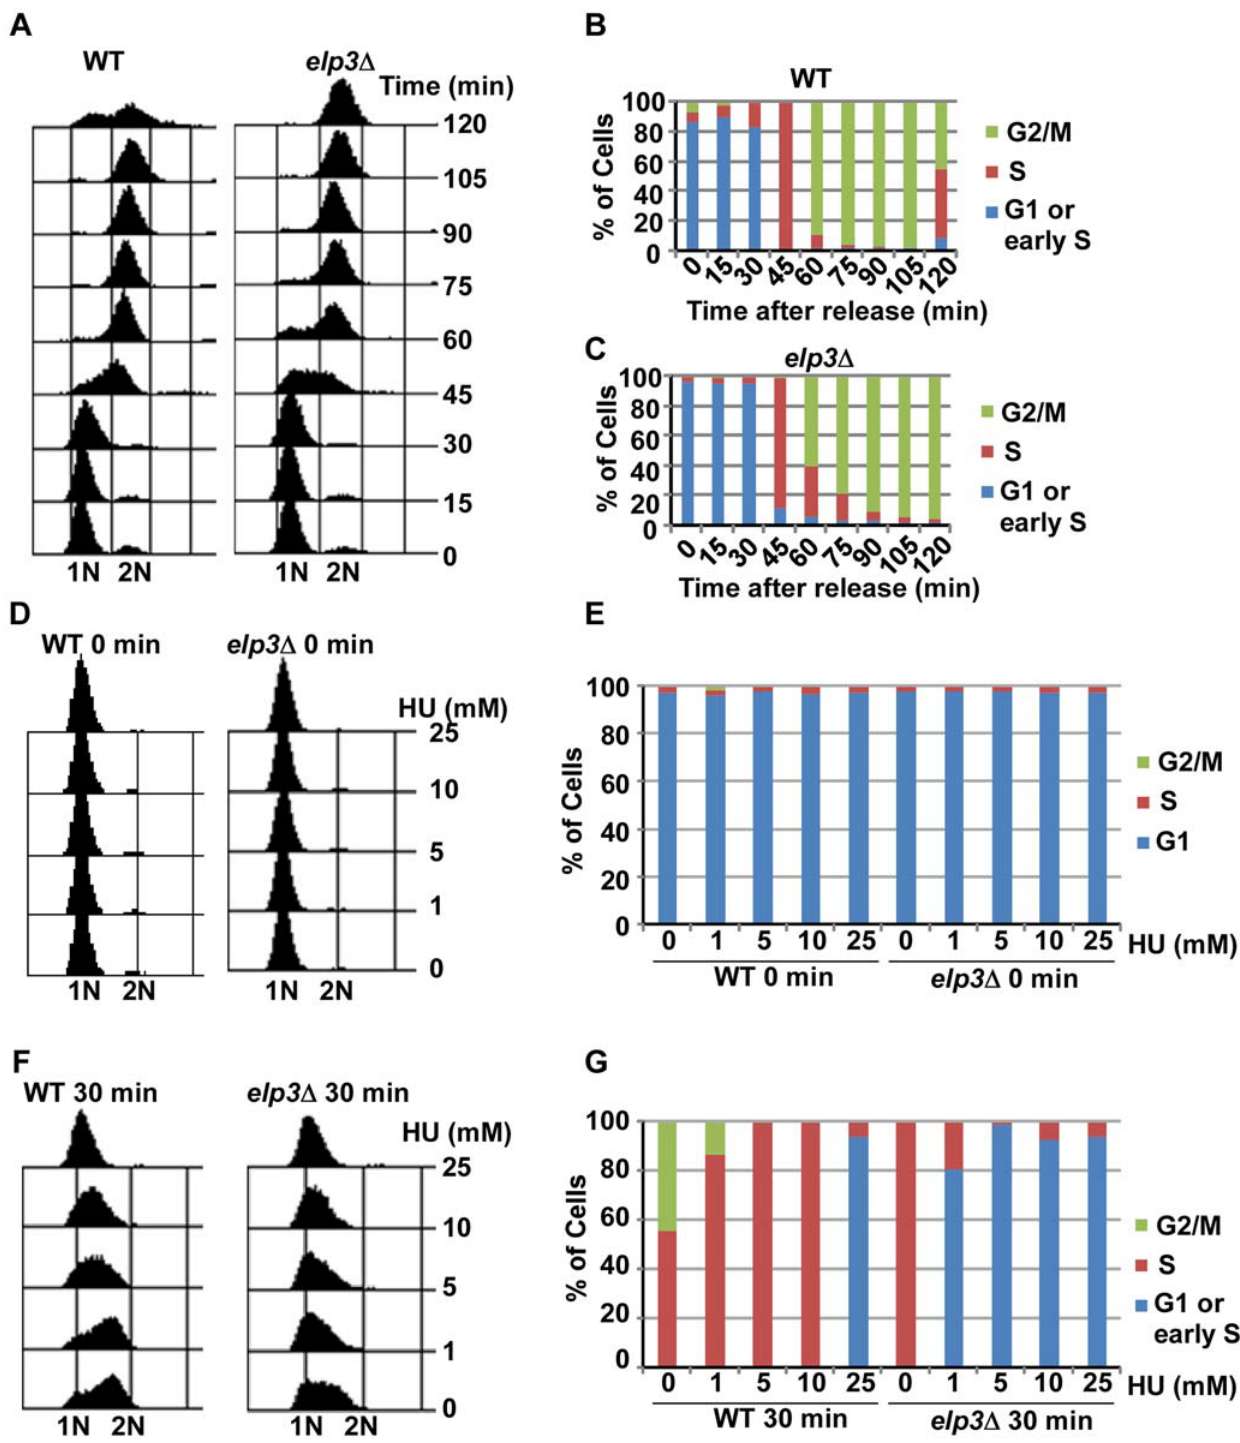
Figure 4. Effect of loss of Elp3 on S-phase progression in the absence and presence of HU. (A–C) The elp3 D mutant cells show slightly delayed in progression through S phase. Wild-type (WT) and elp3 D mutant cells synchronized at G1 with a factor were released into fresh media at 25 u C. Every 15 min after release, cells were collected for analysis of DNA content using flow cytometry. Flow cytometry profiles (A) as well as quantification of the percentage of cells in different cell cycle stage for wild type (B) and elp3 D mutant cell (C) are shown. (D–G) ELP3 depletion is slows or prevents progression through S phase in the presence of low concentrations of Hydroxyurea. Wild-type (WT) and elp3 D mutant cells were arrested in G1 with a factor and released into YPD media containing different concentrations of HU as indicated. Samples were harvested at 0 min in HU (D,E) or 30 min in HU (F,G) for analysis of DNA content by flow cytometry. Flow cytometry profiles (D,F) and quantification of percentage of cells at different cell cycle stage (E,G) were shown.